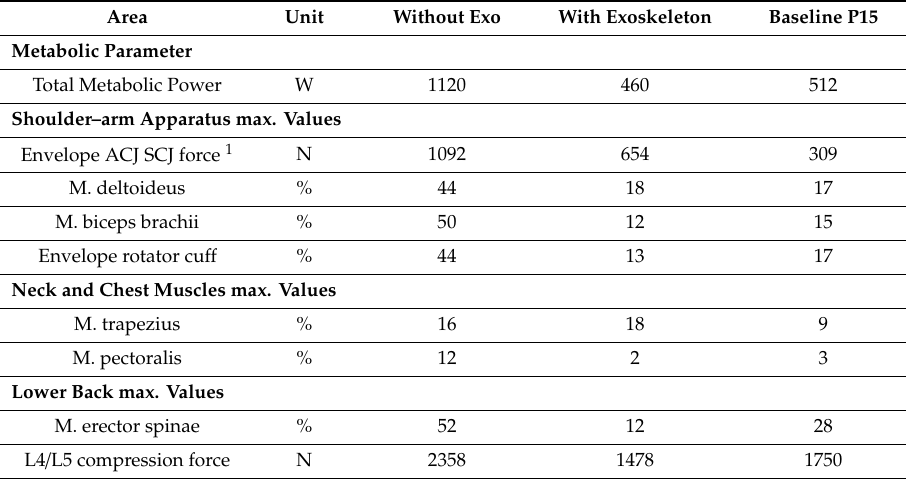
Table 3. Overview of the influence of exoskeleton use on key biomechanical parameters for the pushing task in comparison to those with an exoskeleton, without an exoskeleton and without an exoskeleton and recommended pushing force